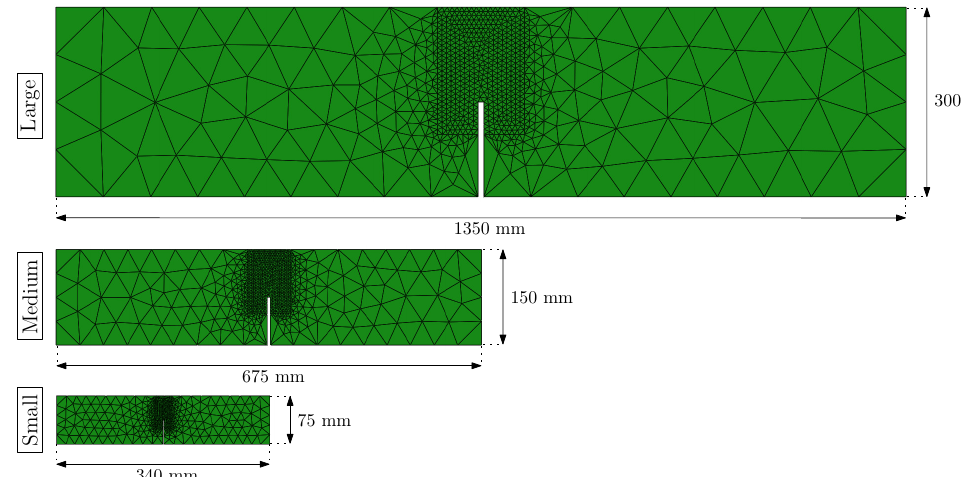
Figure 7. FEM meshes used in the simulations for each specimen